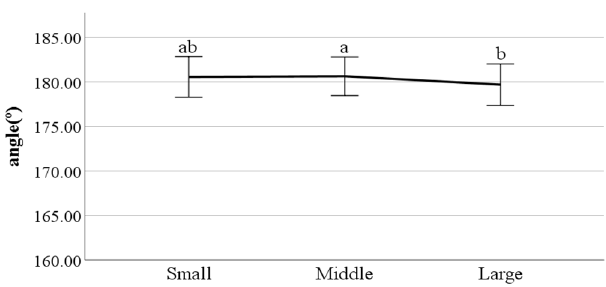
Figure 32. Lateral trunk flexion at the double support phase (right foot forward) (F value: 3.10, DF: 2, p -value: 0.04).